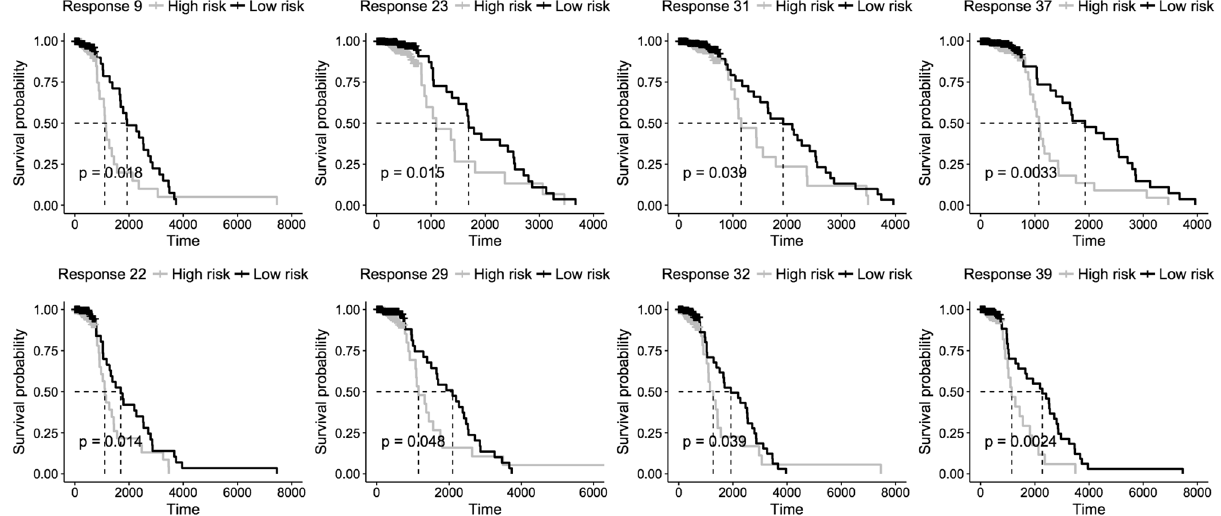
Figure 6. Kaplan–Meier survival analysis for patients in response modules.